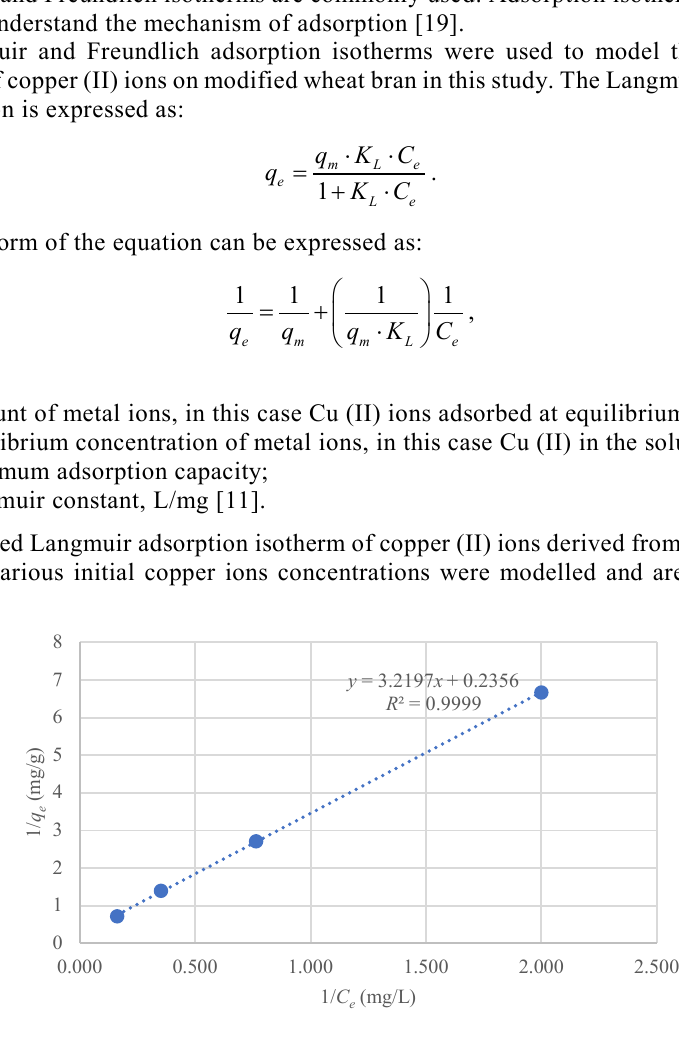
Fig. 6. Langmuir plots for adsorption of Cu (II) by modified wheat bran (1/ q e in mg/g on the y-axis represents the inverse of the amount of Cu (II) ions adsorbed at equilibrium and 1/ C e on the x-axis representing the inverse of the equilibrium concentration of metal ions in the solution in